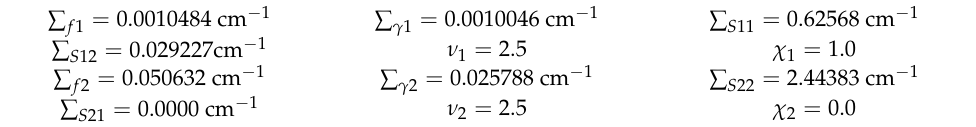
Table 7. Two-group bare reactor cross-sections